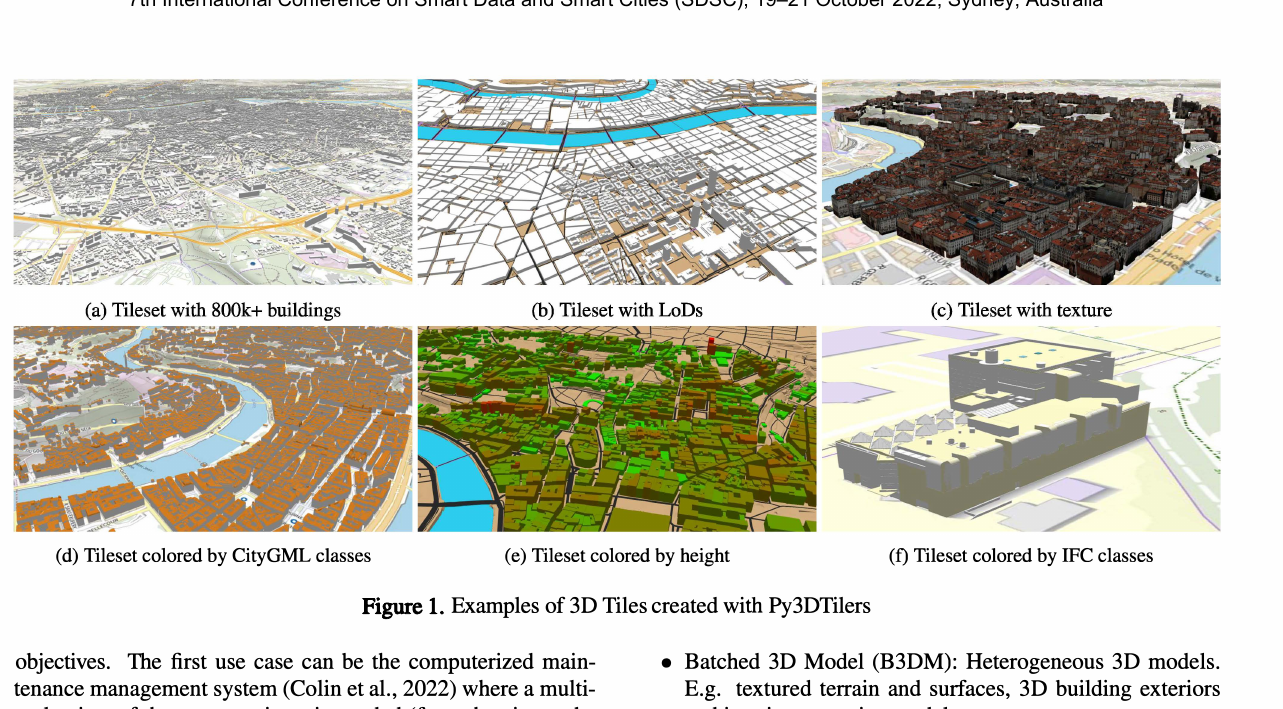
Figure 1. Examples of 3D Tiles created with